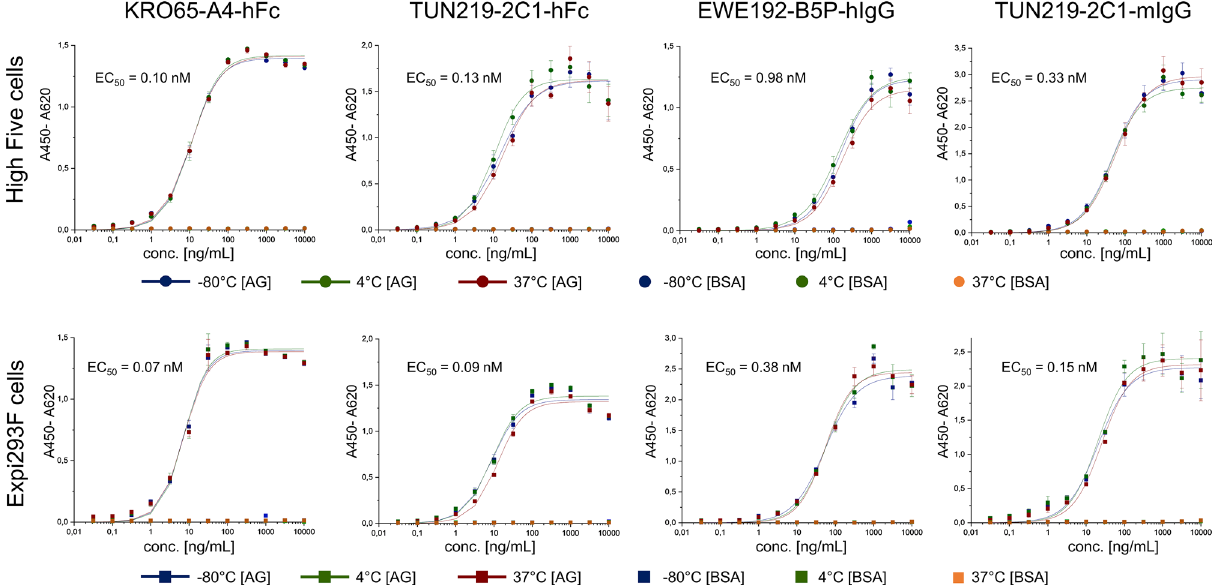
Figure 4. ELISA activity of four different antibodies produced in High Five cells or in Expi293F cells after 30 days of storage at the indicated temperatures. An average EC 50 value of the different antibodies is given including all storage temperatures. Triplicates were measured, the standard deviation is indicated and, unspecific binding to BSA was tested.